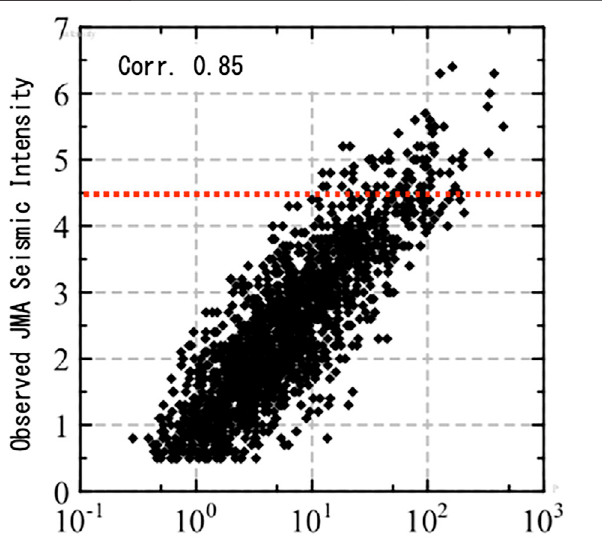
FIGURE 8 | Relationship between peak ground accelerations of the vertical P wave and observed seismic intensities (modi fi ed from Ueda et al.,